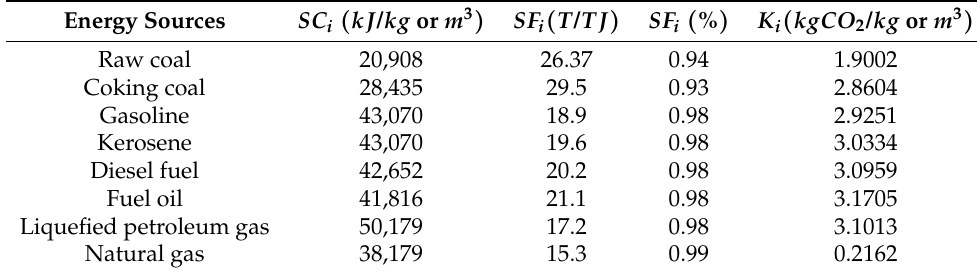
Table 3. Carbon emission coefficient of the eight energy sources.